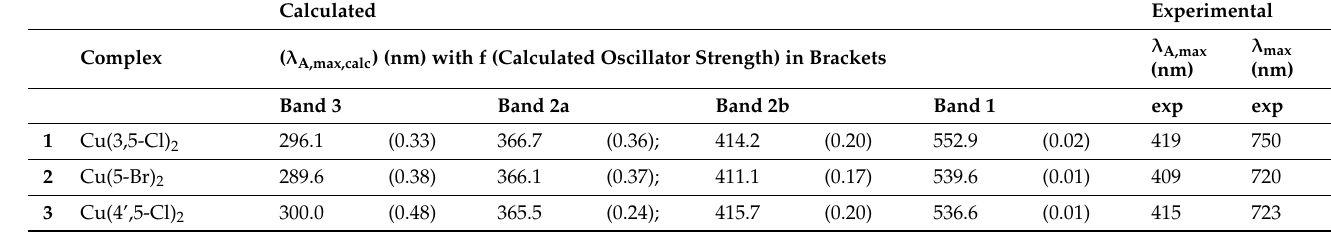
Table 1. B3LYP/6-311G(d,p)/def2-TZVPP calculated absorbance maximum wavelength ( λ max,calc ), oscillator strengths (f), as well as the experimental maximum wavelength ( λ max ) and maximum absorbance ( λ A,max )